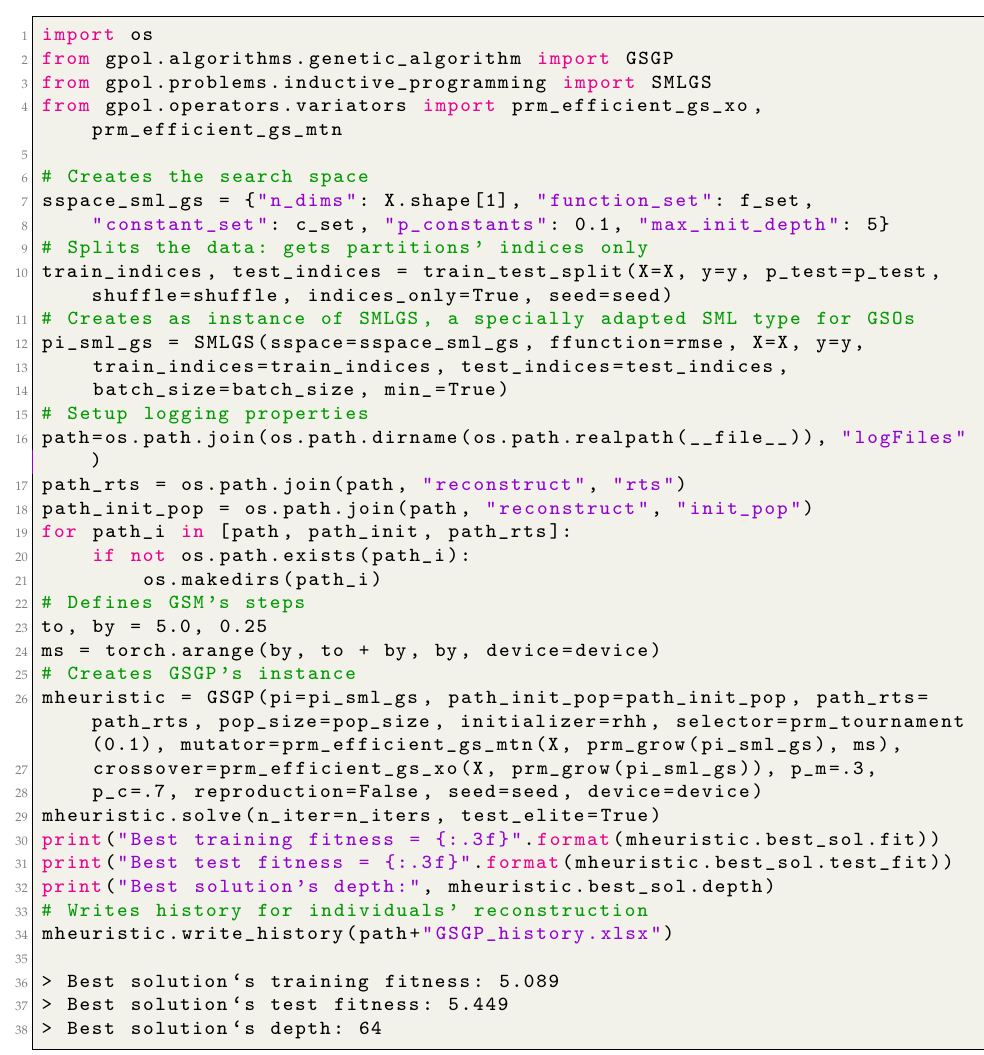
Figure A8. An example of GSGP being used in symbolic regression problem